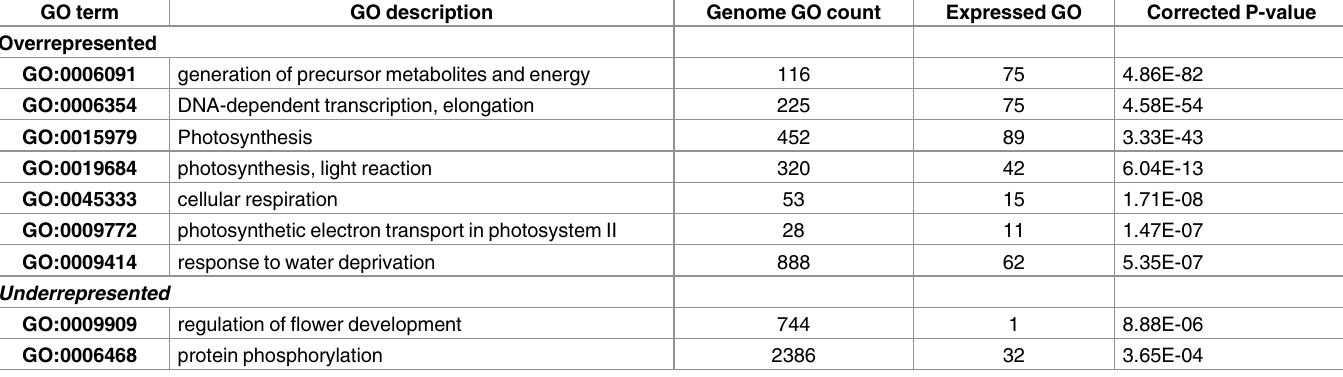
Table 4. GO enrichment analysis of the 1318 differentially expressedtranscripts that are significantly lower at stage 9 compared to prematurely dried seeds at stage 7.2. GO